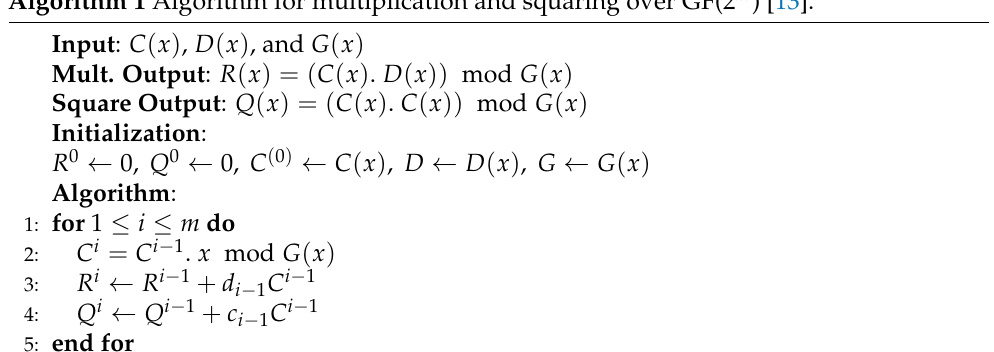
Algorithm 1 Algorithm for multiplication and squaring over GF(2 m )